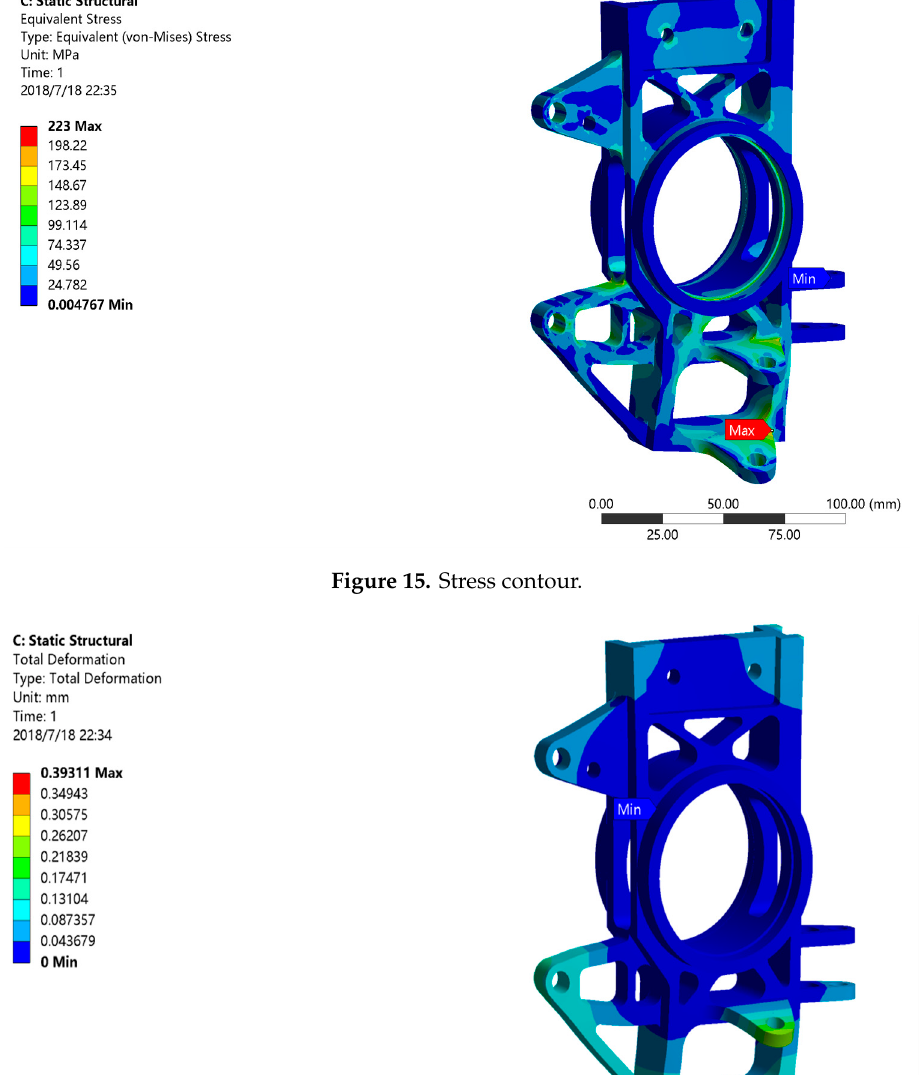
Figure 14. Initial finite element model.